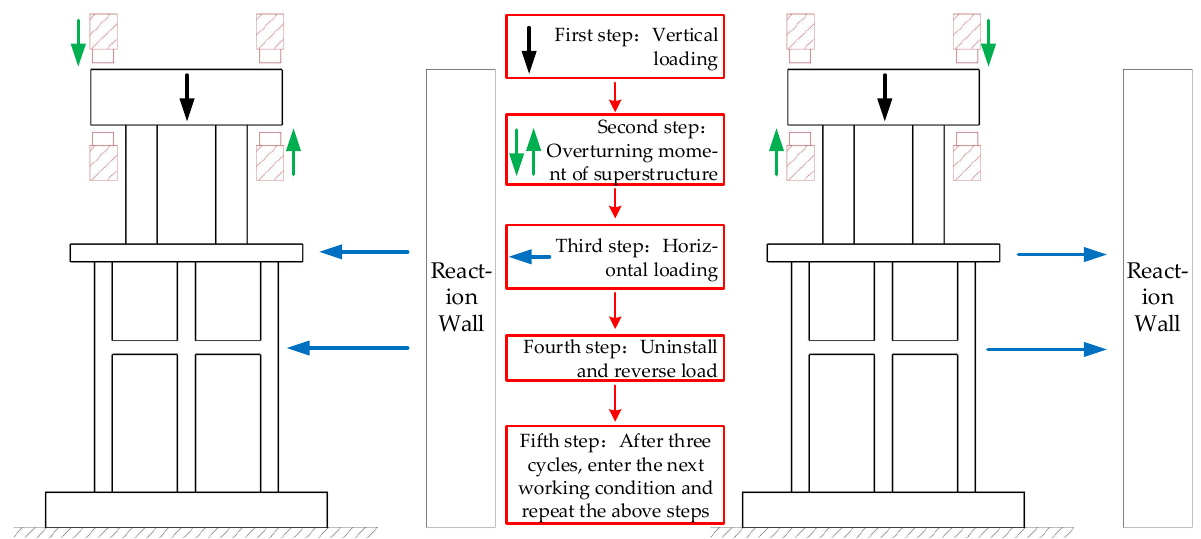
Figure 10. Loading diagram (the left image is positive loading and the right image is negative loading).